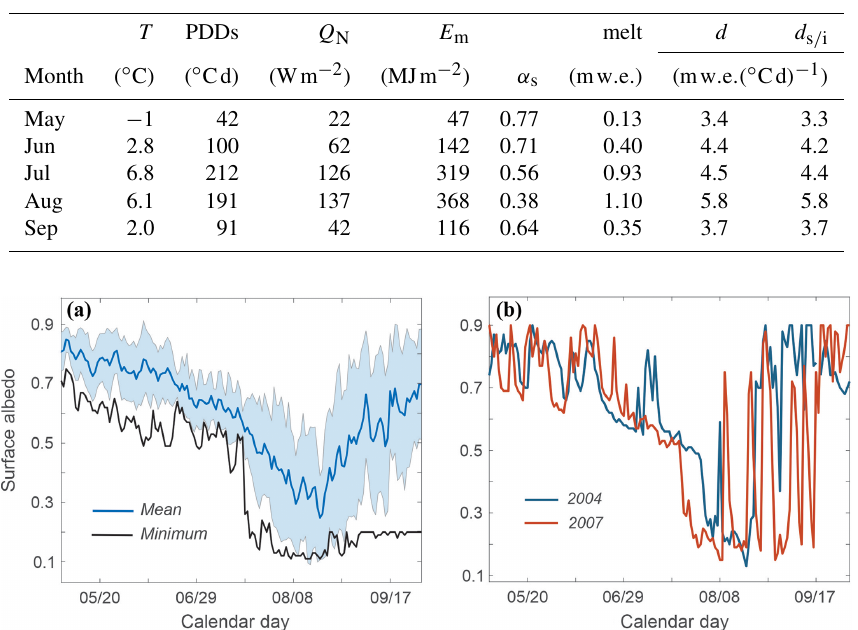
Table 2. Mean monthly temperature, surface energy balance, and melt conditions at the Haig Glacier AWS, 2002–2015. Symbols are as in Table 1, with the addition of degree-day melt factors, d , calculated from Eq. (6) and the conventional version, d s / i , calculated from Eq. (5).